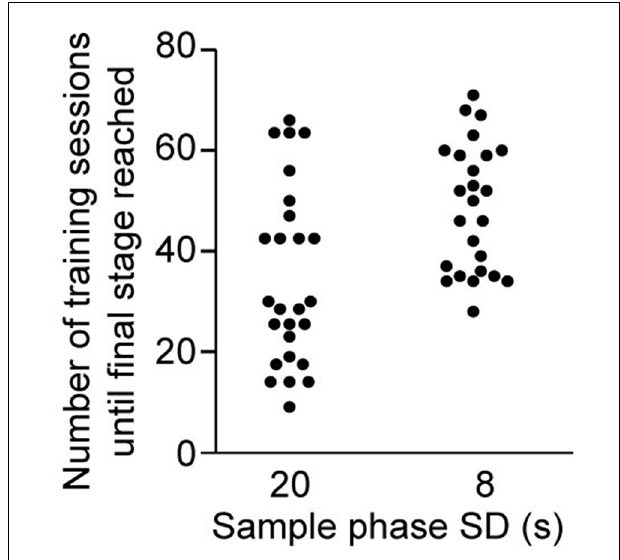
FIGURE 3 | Training demand for DMTP dark protocol. Number of daily 30-min training sessions required to transition to stage 3 (see Figure 1D ) with an SD of 20 s or 8 s, as indicated ( n = 26, of which one mouse did not reach the 8 s—SD substage within 75